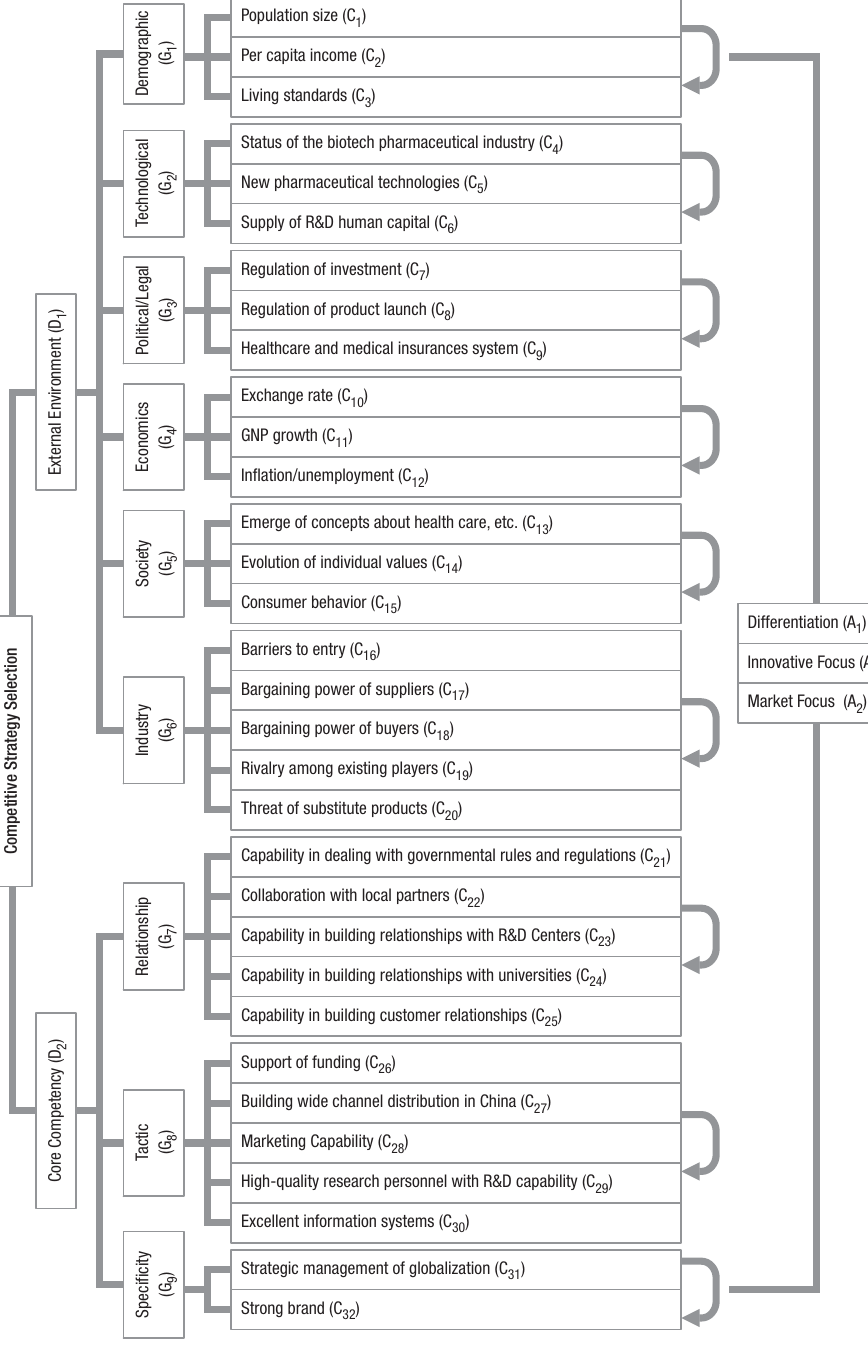
Fig. 4. The ANP model for competitive-strategy